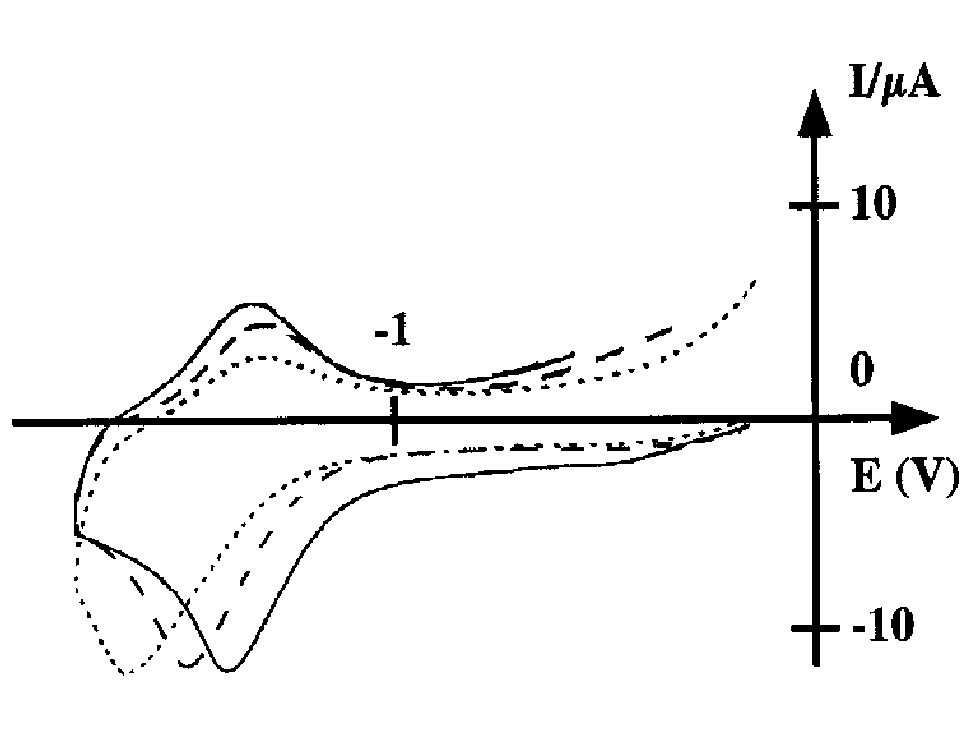
Figure 3 : Cyclic voltammogram for poly 2, G = 4.9 nmolcm -2 , in CH 3 CN + 0.1 M TBAP. Scan rate: 20 mVs -1